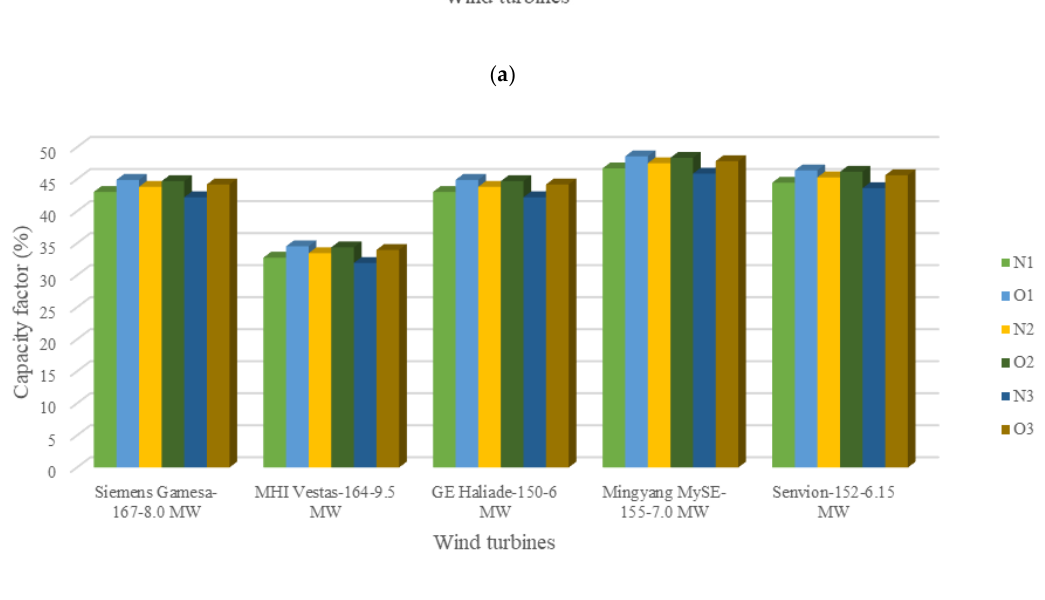
Figure 5. ( a ) Annual energy production and ( b ) capacity factor expected from each type of turbine for six sites in Black Sea using the wind data for the near future.